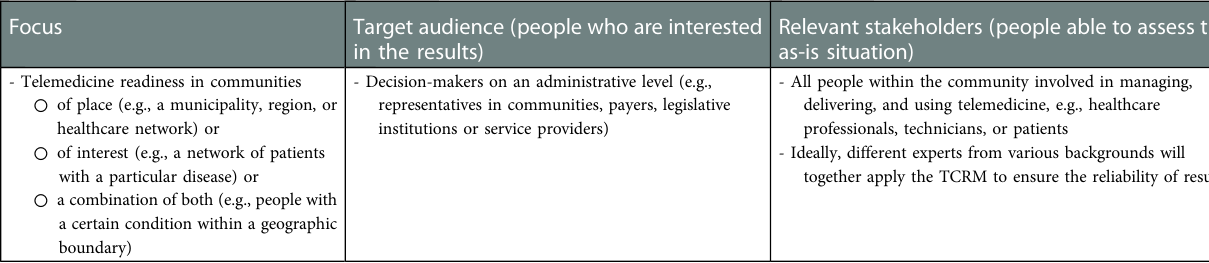
TABLE 2 Scope of the